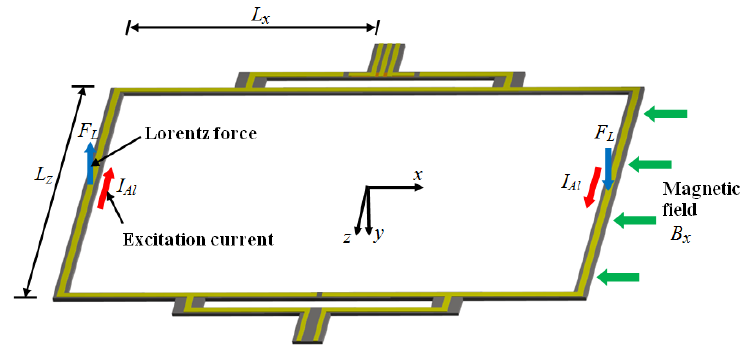
Figure 6. 3D schematic view of the performance of a MEMS magnetic field sensor formed by a rectangular loop of silicon beams, an aluminum loop and piezoresistive sensing [21]. Reprinted with permission from [21]. Copyright© 2011, Elsevier B.V.